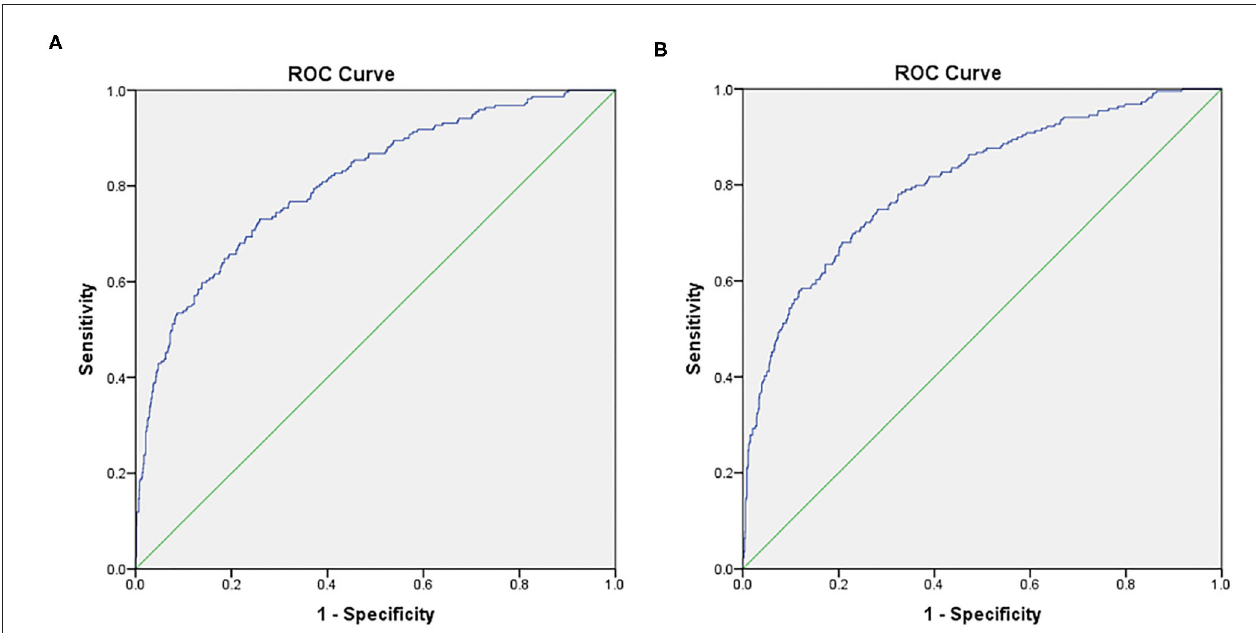
FIGURE 1 | Receiver operating characteristic (ROC) curves for the two models of multivariate logistic regression analyses in predicting the presence of PLEs. The area under the curve (AUC) was estimated to be 0.808 (95% CI: 0.775 to 0.841) for the first model with a sensitivity of 73.1% and a specificity of 74.1% (A) ; and was 0.807 (95% CI: 0.774 to 0.840) for the second model with a sensitivity of 68.0% and a specificity of 79.3% (B)